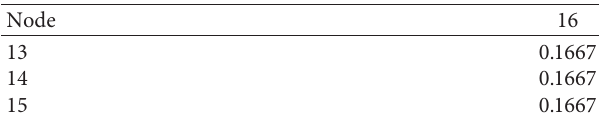
Table 6: Quality risk propagation coefficient matrix of the third- level to fourth-level